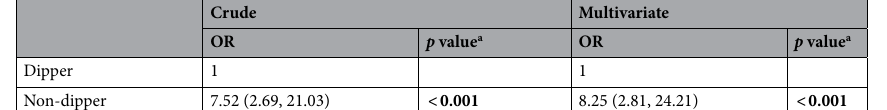
Table 5. Association between dipping pattern and macular ischemia using logistic regression analysis. Adjusted for variables in basic and clinical parameters associated with blood pressure (age, sex, body mass index, current smoking status, and alcohol drinking status). Night to day systolic blood pressure ratio (%) = (Daytime sysBP − Nighttime sysBP)/Daytime sysBP × 100. Dipper ≥ 10%; Non-dipper < 10%. Statistically significant values appear in boldface. a Based on logistic regression analysis.